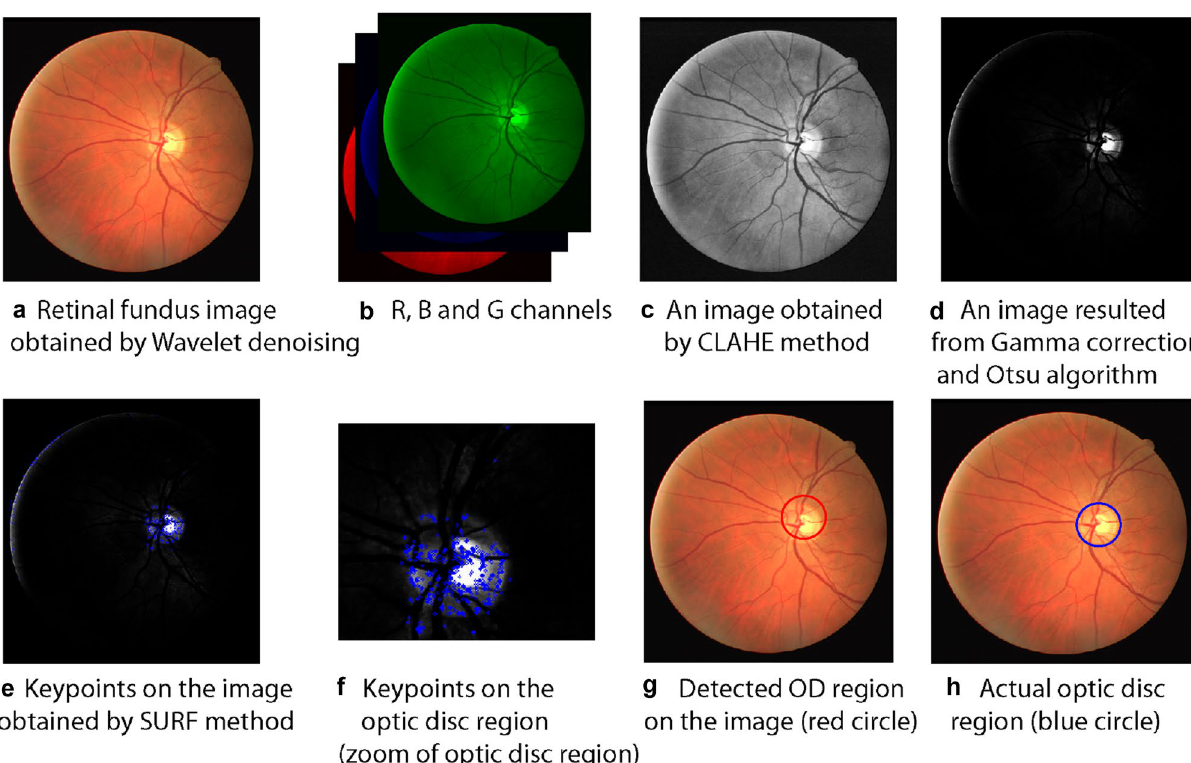
Fig. 4 Steps of the optic disc detection applied in this